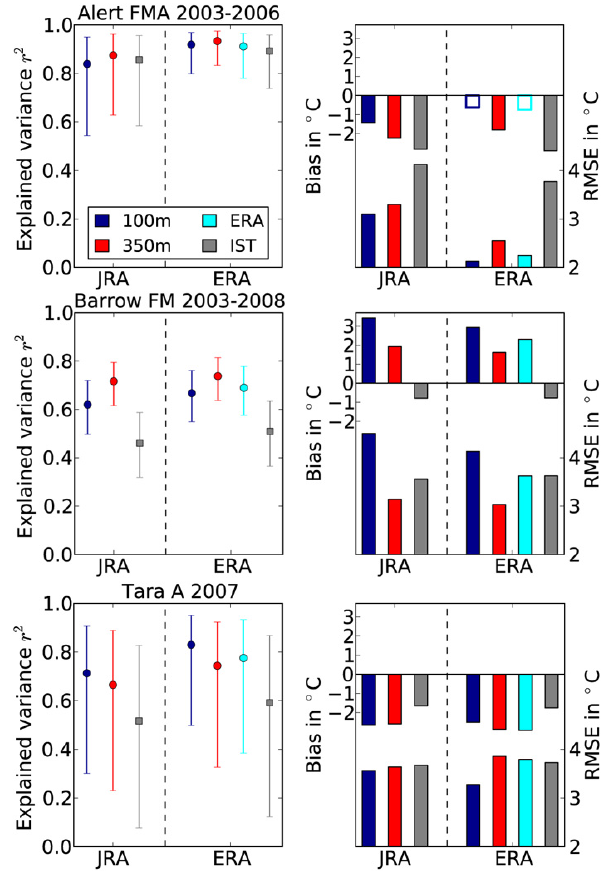
Fig. 8. Explained variances between observed 2-m air temperatures at the stations and modeled temperatures (AT method, colored), as well as mean ice surface temperatures along the trajectories (gray) with 95% confidence intervals (left), bias and RMSE (right) for Alert (upper), Barrow (middle) and Tara (lower), using AA ice con- centrations. The colors denote the BL depths. The blank bars are not significant at the 95%